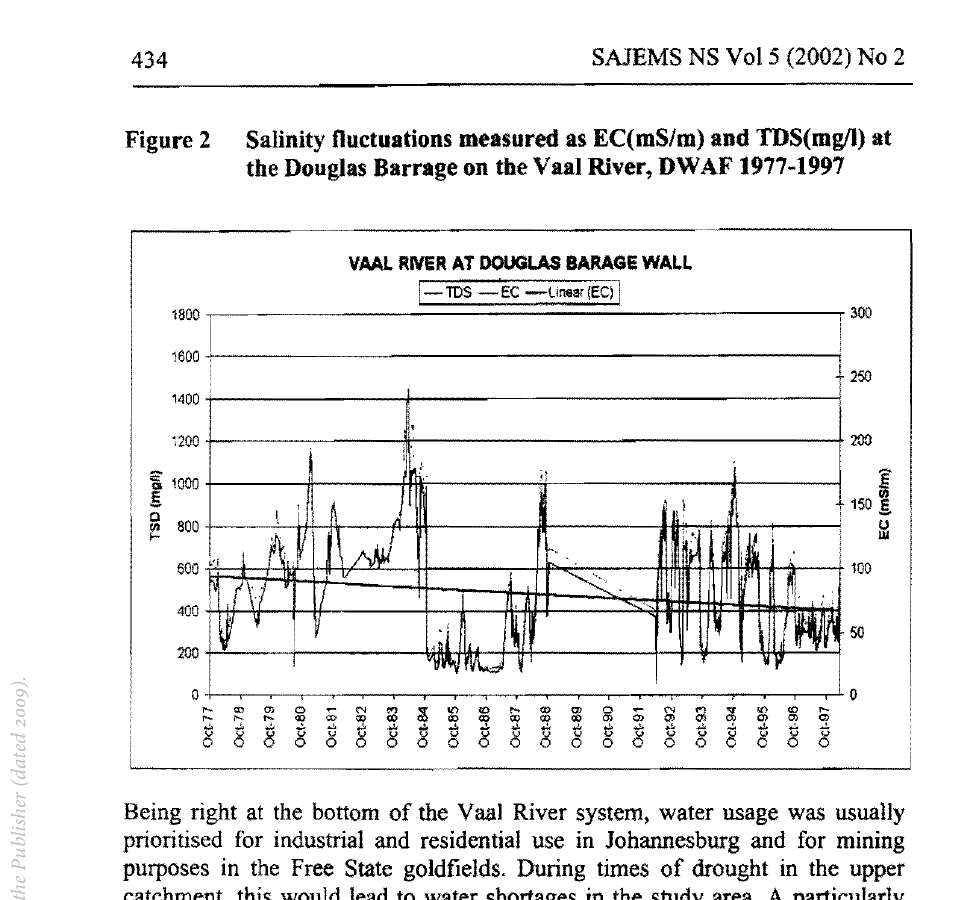
Salinity fluctuations measured as EC(mS/m) and TDS(mgll) at the Douglas Barrage on tbe Vaal River, DW AF 1977-1997